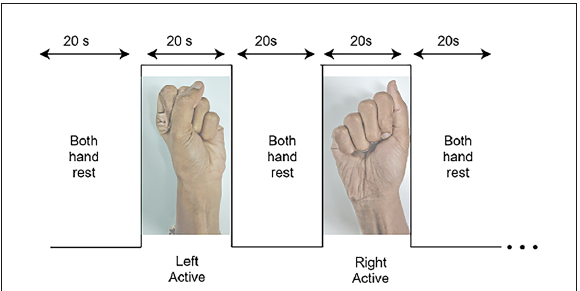
FIGURE4 Dataset A: The paradigm for the experimental procedure includes rest and active motor tasks: right- and left-hand motor execution, starting from rest-state on both hands followed by left-hand motor execution task then both hand rest followed by right-hand motor